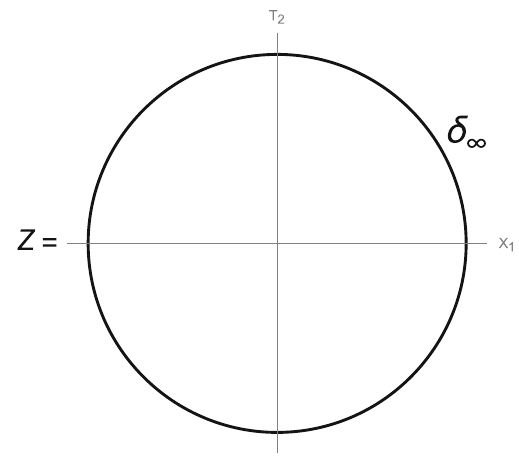
Fig. 4 The disk geometry that geometrically represents the partition function associated with the state in Fig.